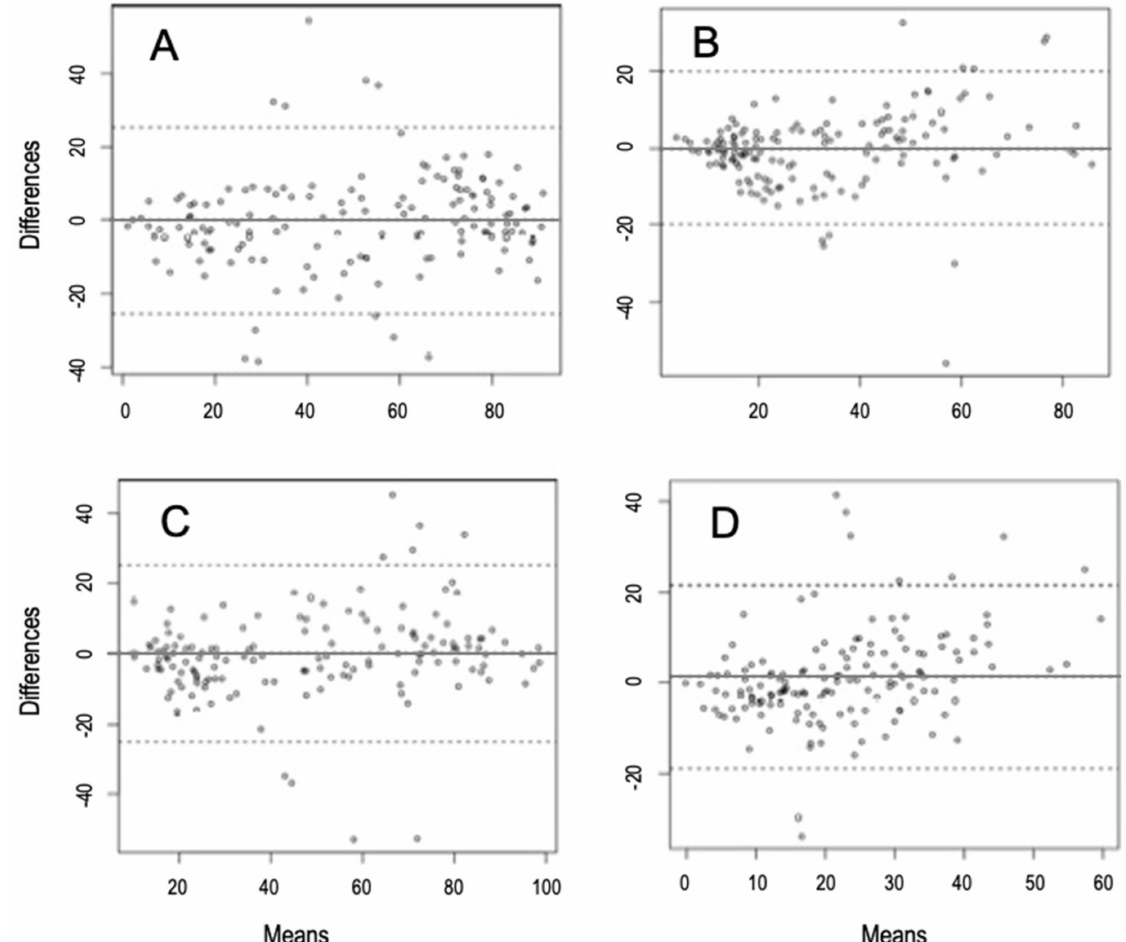
Figure 4. Bland–Altman plots showing the agreement between fecal cuticle microhistological analysis (CMA) and near infrared reflectance spectroscopy (NIRS) predictions for four functional groups of plants: woody ( A ), herbaceous ( B ), graminoids ( C ) and Fabaceae ( D ) found in fecal samples of Pyrenean chamois. Y axis represents the difference between the proportion of each functional group of plants observed by the CMA and the NIRS predictions. X axis represents the mean of the observed and the predicted proportion for each functional group of plants. The limits of agreement (dotted line), from-1.96SD (standard deviation), to +1.96SD have also been